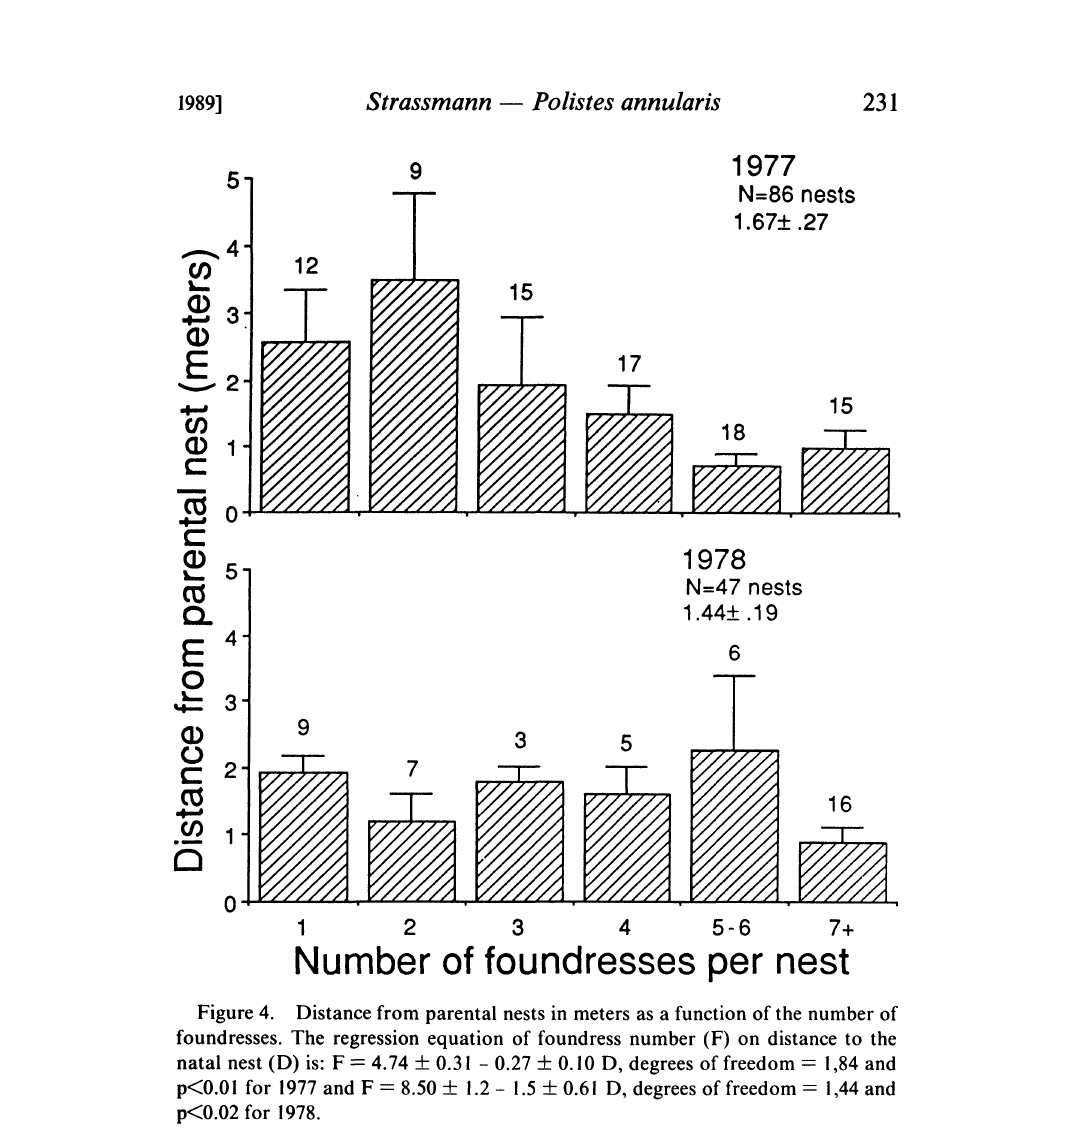
Figure 4. Distance from parental nests in meters as a function of the number of foundresses. The regression equation of foundress number (F) on distance to the natal nest (D) is: